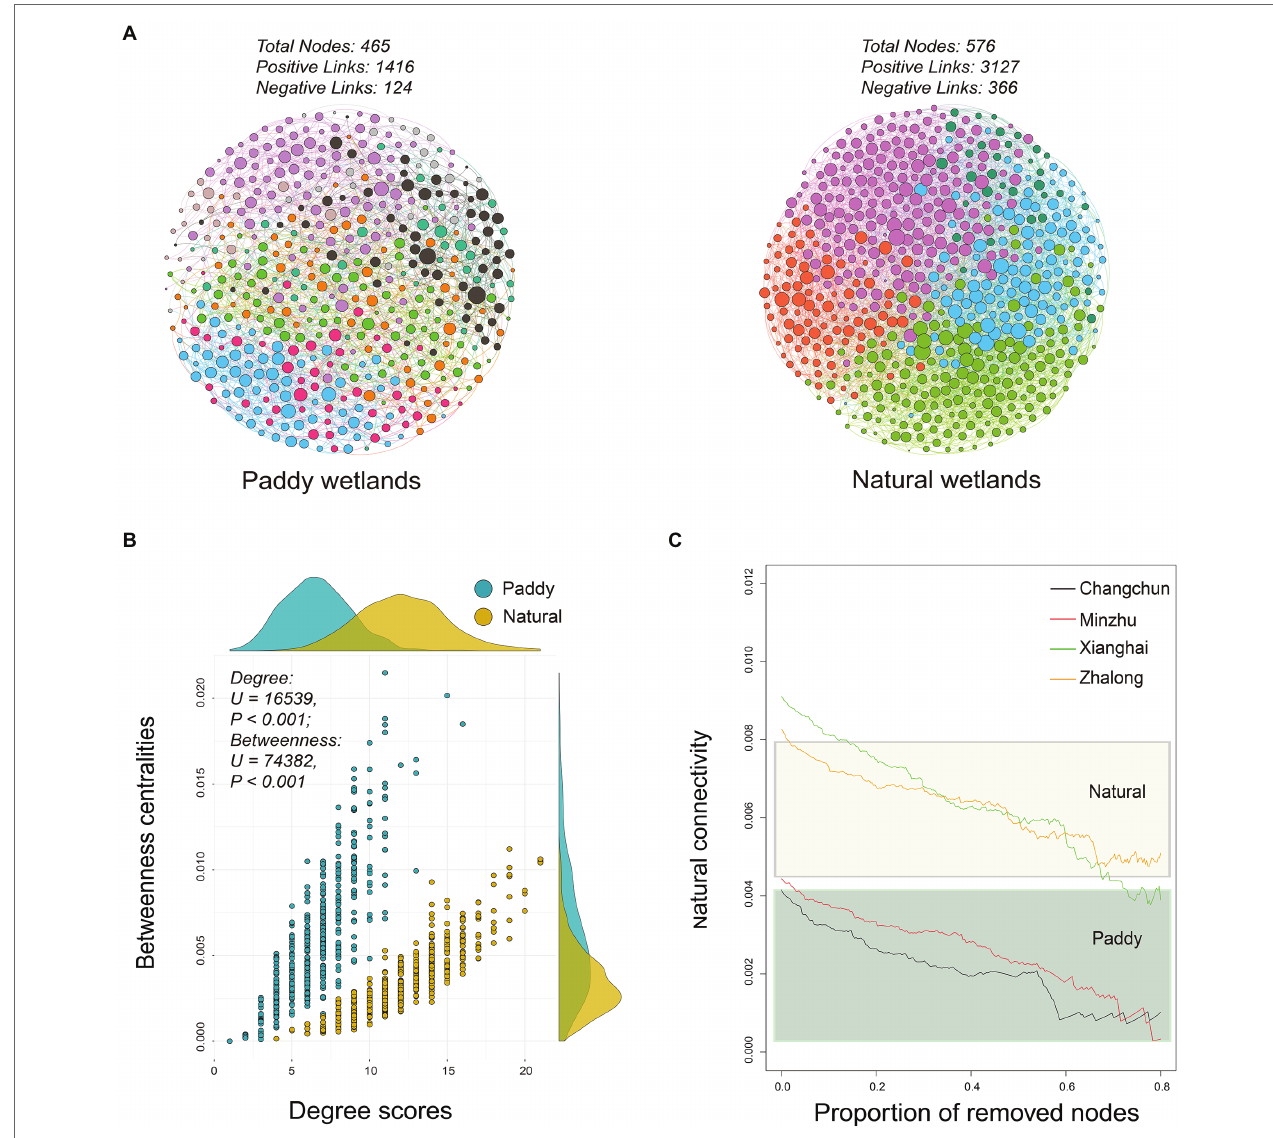
FIGURE 4 | (A) Networks visualizing co-occurring phylotypes of active methanotrophs in paddy and natural wetlands. All co-occurrence networks were analyzed by Spiec-Easi method. Colorful nodes represented different ecological module affiliations of active methanotrophs and edges on behalf of potential ecological co- occurring relationships. (B) Relationships between degree scores and betweenness centralities in active methanotrophic co-occurrence networks of four wetland soils. The difference test was adopted by Mann–Whitney U test. (C) Network robustness analysis of active methanotrophic co-occurrence networks in four wetland soils, measured as natural connectivities with remained proportion of